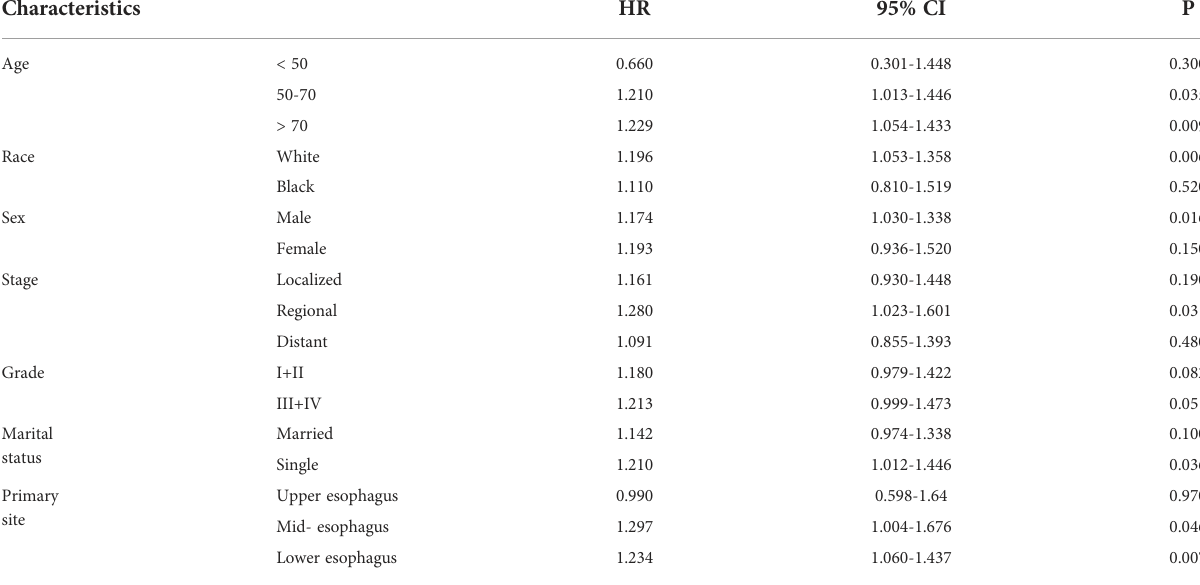
TABLE 4 Effects of radiotherapy on CVD related death in EC patients with different characteristics.